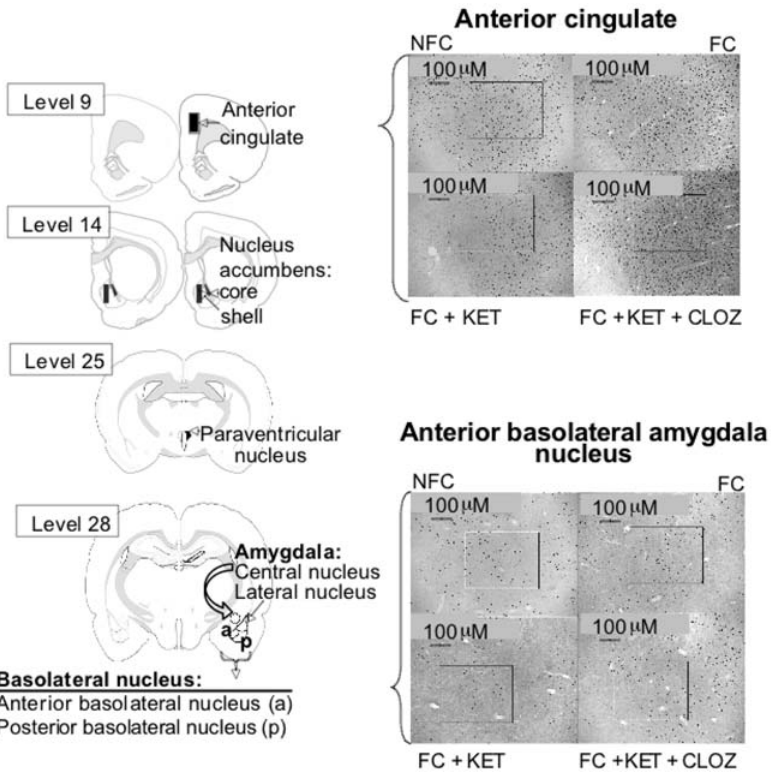
Figure 5. cFos immunocytochemical labeling. Typical examples of the brain areas stained for cFos expression, visually showing the effects of some of the treatments. Delineated areas depict areas measured. Brain slice levels were taken from the Swanson rat brain atlas [65], with appropriate co- ordinates listed in Table 1. CLOZ, clozapine; FC, Fear conditioning; KET, ketamine; NFC, no fear conditioning.